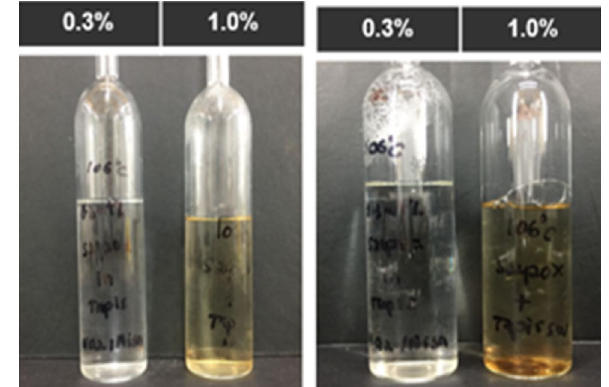
Fig. 10 APG surfactant compatibility and solubility at 0.3% and 1.0 wt% concentration, at 80 °C after 30 days (left) and 60 days (right)